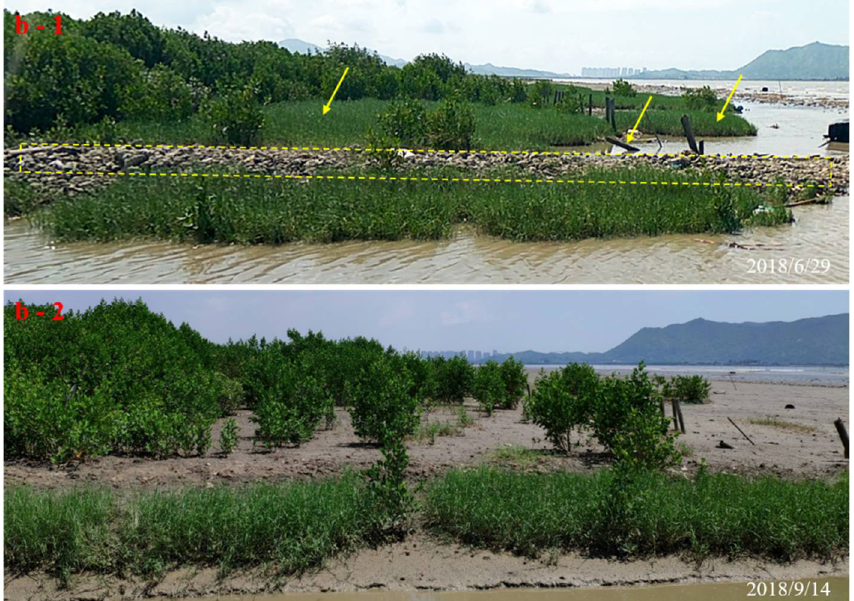
Figure 10. Comparison of tidal flats with both mangrove seedlings and salt grasses in region b (red box b in Figure 8) on June 29 ( b-1 ) and September 14 ( b-2 ), during which obvious sedimentation occurred in this region, e.g., the arrow pointed grasses, bamboo, and the yellow-line bounded rocks were all buried by sediments.